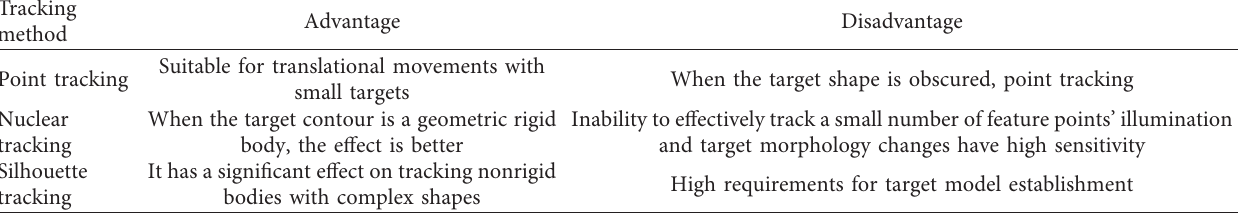
Table 1: Comparison of the analysis of three tracking